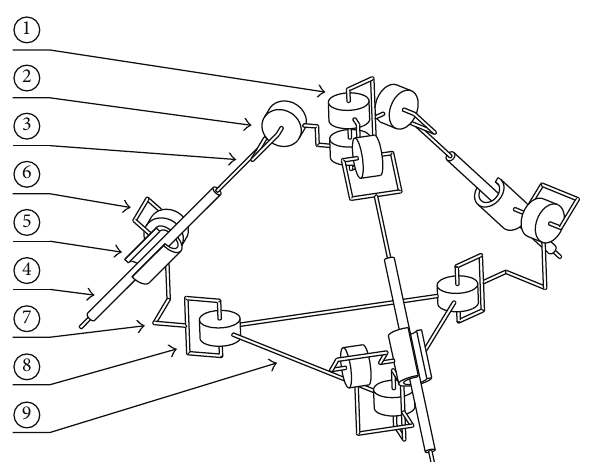
Figure 1: Structure of a 5-DOF spatial parallel micromanipulator: A : moving platform, B , F , and H : revolute joint, C : connector, D : actuator shaft, E : stator, G : support, and 0 : microrobot’s base.